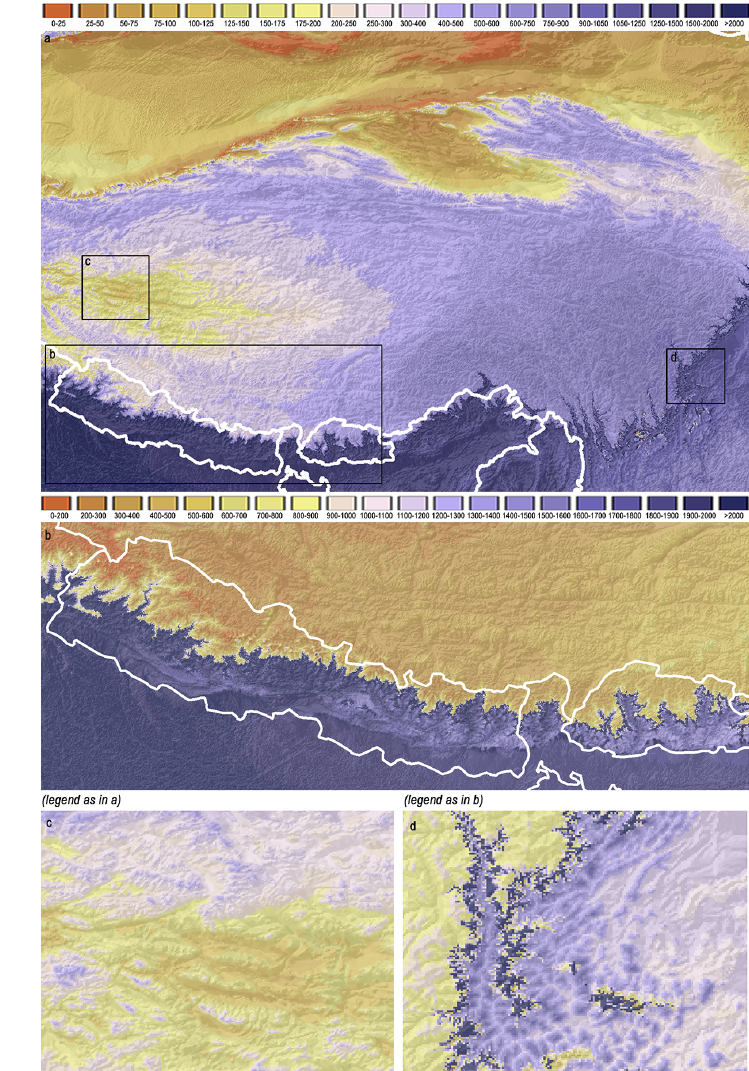
Figure 8. Modeled mean annual precipitation sums [mm] for the entire target domain (a) and enlargements of the central Himalayan Arc (b) , the western Tibetan Plateau (c) and the margins of the Red Basin (d)